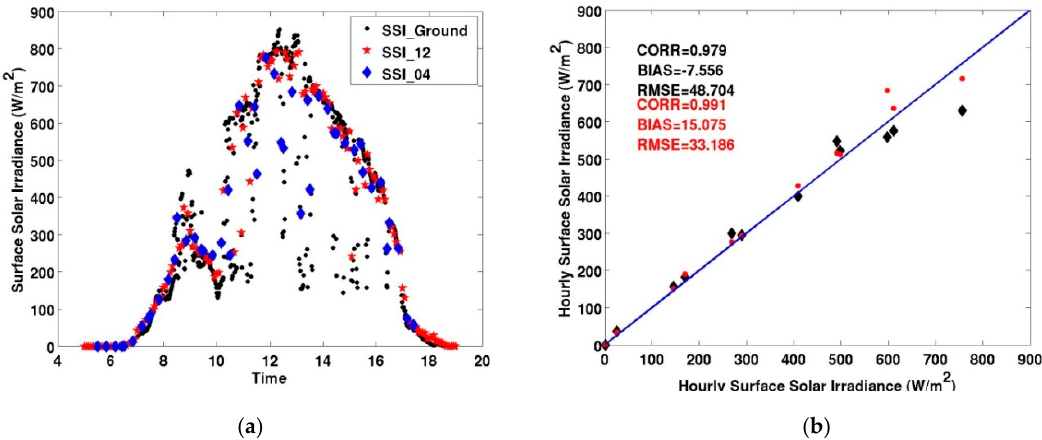
Figure 6. Data from 20 March 2018 at JRC. ( a ) Surface solar irradiance estimate by AMESIS based on 4- (SSI_04) and 12- (SSI_12) hourly samples, against measurements by ground-based pyranometers (SSI_ground); ( b ) Scatter plot of the AMESIS hourly surface solar irradiance estimates based on 4- (black diamonds) and 12- (red circles) hourly samples against the irradiance measured with the pyranometer.